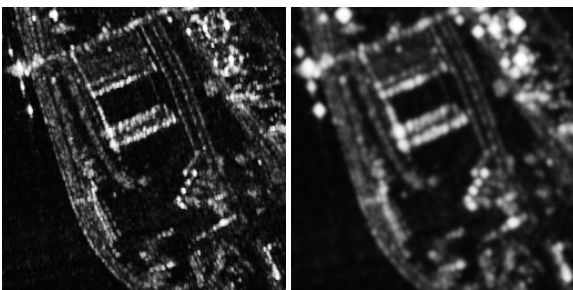
Figure 4. Subset of a TerraSAR-X spotlight acquisition over the harbor area of Mannheim-Ludwigshafen in Germany. For the left image only one look, whereas for the right image 64 looks are applied (Schmitt et al., 2015).